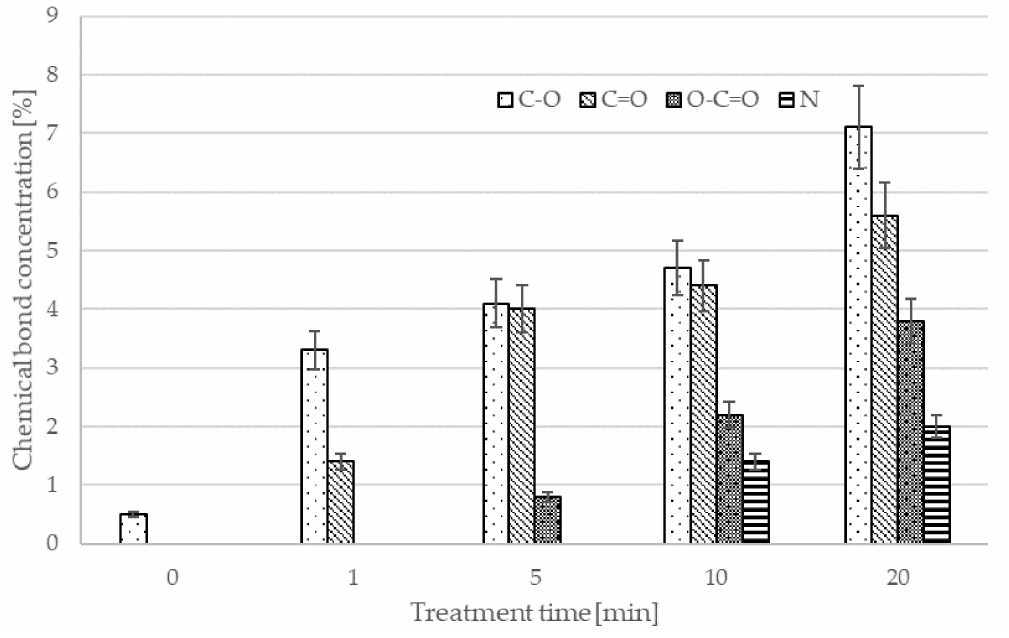
Figure 3. Dependence of chemical composition of the surface film on treatment time in air